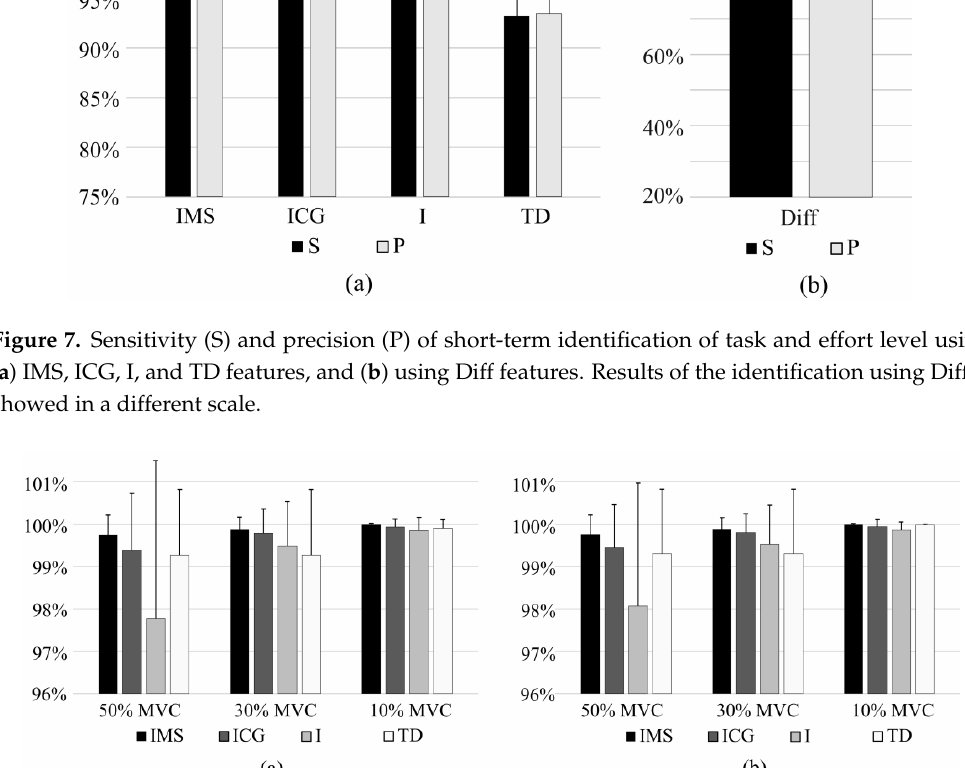
Figure 7. Sensitivity (S) and precision (P) of short-term identification of task and effort level using ( a ) IMS, ICG, I, and TD features, and ( b ) using Diff features. Results of the identification using Diff is showed in a different